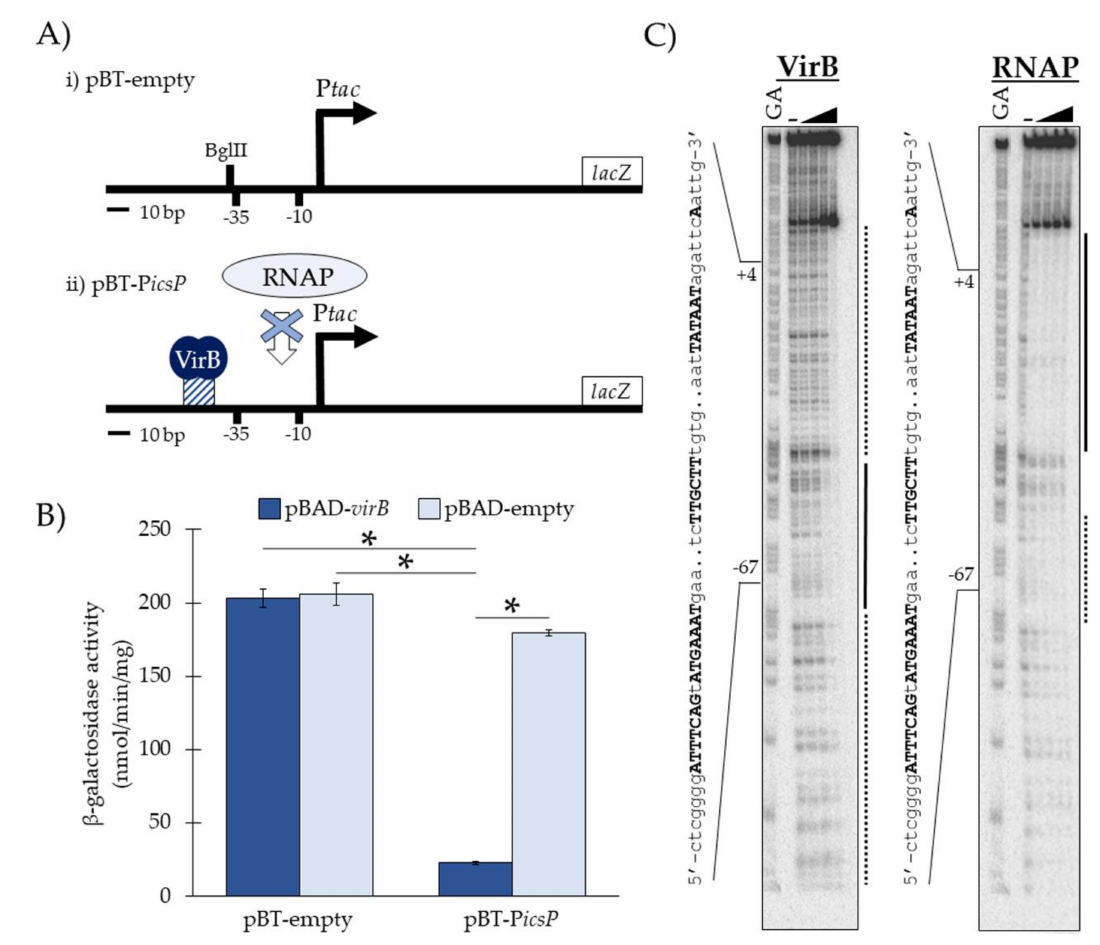
Figure 1. Schematic and validation of the in vivo binding tools pBT-empty and its derivative pBT-P icsP . ( A ) Schematic of (i) pBT-empty and (ii) pBT-P icsP , showing the hypothesized steric hindrance of RNA polymerase (RNAP) when VirB engages its binding site. ( B ) P tac promoter activity associated with pBT-empty or pBT-P icsP in the presence (pBAD- virB ) or absence (pBAD-empty) of VirB in a S. flexneri virB mutant, as determined by β -galactosidase assays. Assays were conducted in triplicate, and representative data of three independent trials are shown. A Student’s t -test was used to measure statistical significance, * p < 0.001. ( C ) DNase I protection assays showing that VirB and RNAP occupy overlapping regions in pBT-P icsP. Lanes are organized (left to right): A+G sequencing ladder [21] and template DNA (6.4 nM) incubated with zero (-) or increasing final concentrations of His 6 -tagged VirB (30.7, 61.4, 122.8, or 307 nM) or RNA polymerase (0.0125, 0.025, 0.05, or 0.1 units µ L − 1 ). Black lines represent regions protected from DNase I at low concentrations (i.e., high affinity protein-DNA binding); whereas dotted lines represent regions protected from DNase I at high concentrations (i.e., low affinity protein-DNA binding). Bold and uppercase text are the VirB-binding site (inverted repeat), promoter elements ( − 35 and − 10) and transcription start site